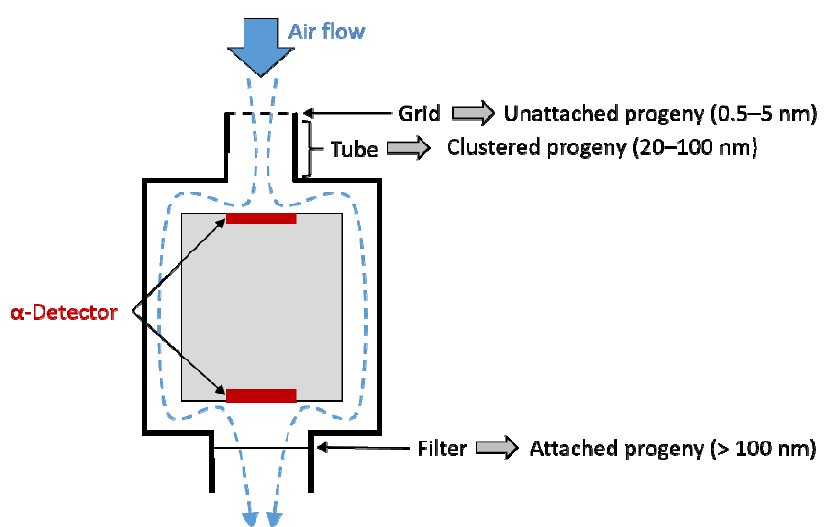
Figure 2. Schematic drawing of the sampling head used to measure radon and radon progeny (EQF 3220, Sarad GmbH, Dresden, Germany) with size fractions assigned to their component where they attach. Air passes through the device, and unattached progeny are retained in the grid, while clustered progeny mainly remain stuck at the tube and attached progeny at the filter, respectively.